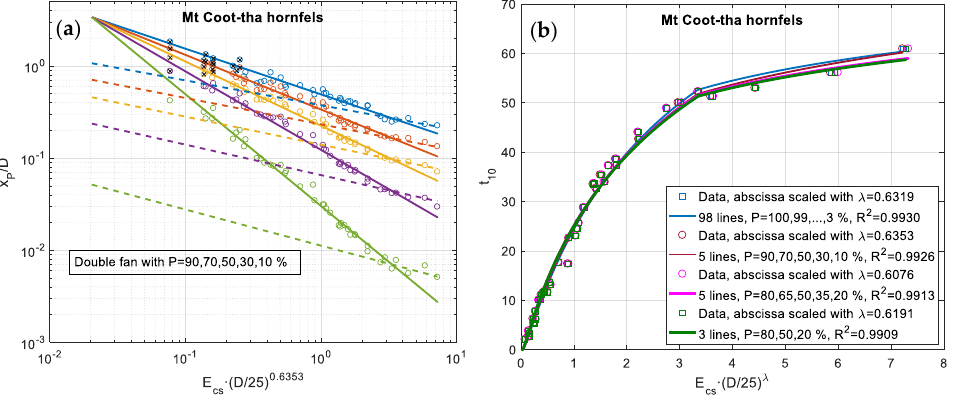
Figure 4. A double fragmentation-energy fan, with kinks on the 𝑥 𝑃′ (𝐸′) fan lines at 𝐸 ∗ . P 1 , P 2 , P 3 are percentage passing, P 1 > P 2 > P 3 .